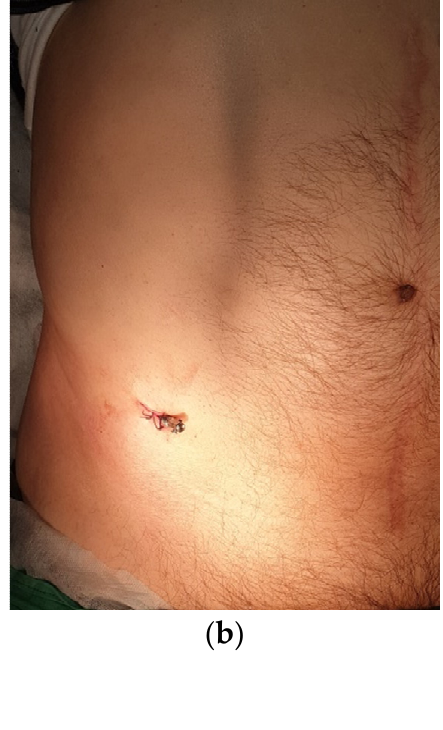
Figure 1. ( а ) MRI of the small pelvis with intravenous amplification—frontal projection; ( b ) MRI of